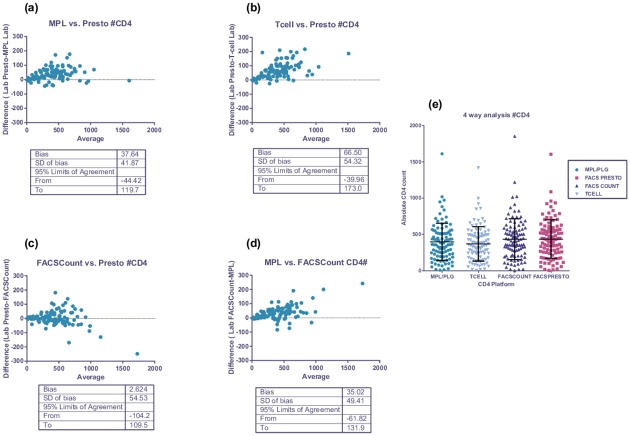
4 way sub-analysis of FACSPresto™ performance.Legend: This figure represents Bland-Altman analysis for absolute CD4 counts where results of the FACSPresto™ were compared to the following predicate methods: (a) MPL using PLG/CD4 platform; (b) T-cell tetrachrome and (c) BD FACSCount™. (d) Comparison of MPL (PLG/CD4) against FACSCount™ indicated equivalent performance to FACSPresto™ against this predicate. Comparative 4-way analysis of CD4 platform performance for absolute CD4 count enumeration (e) confirmed good correlation with no significant differences between datasets (p>0.05).